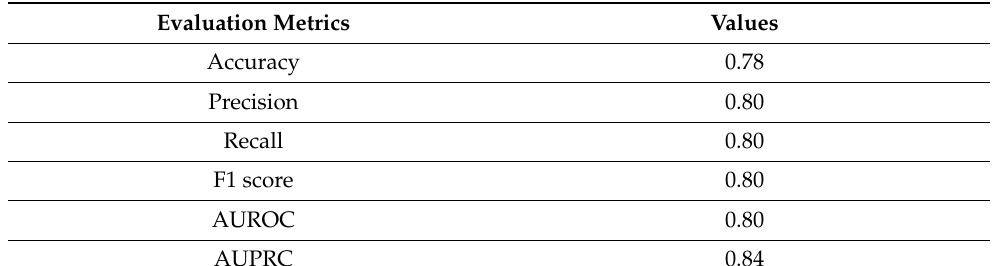
Figure 5. Confusion matrix of the result of proposed classification model. The numbers of true pos- itives, true negatives, false positives, and false negatives are 386, 302, 98, and 94, respectively.